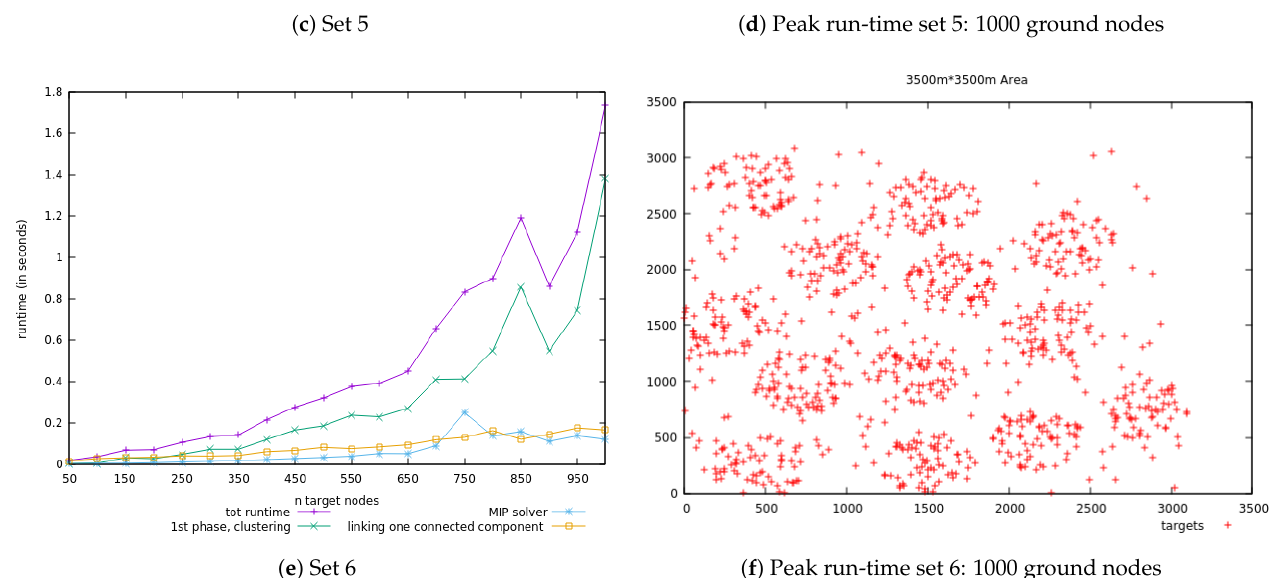
Figure 10. Datasets overall run-time and specific to the 3 main steps; and distribution of instance with highest execution time (Part